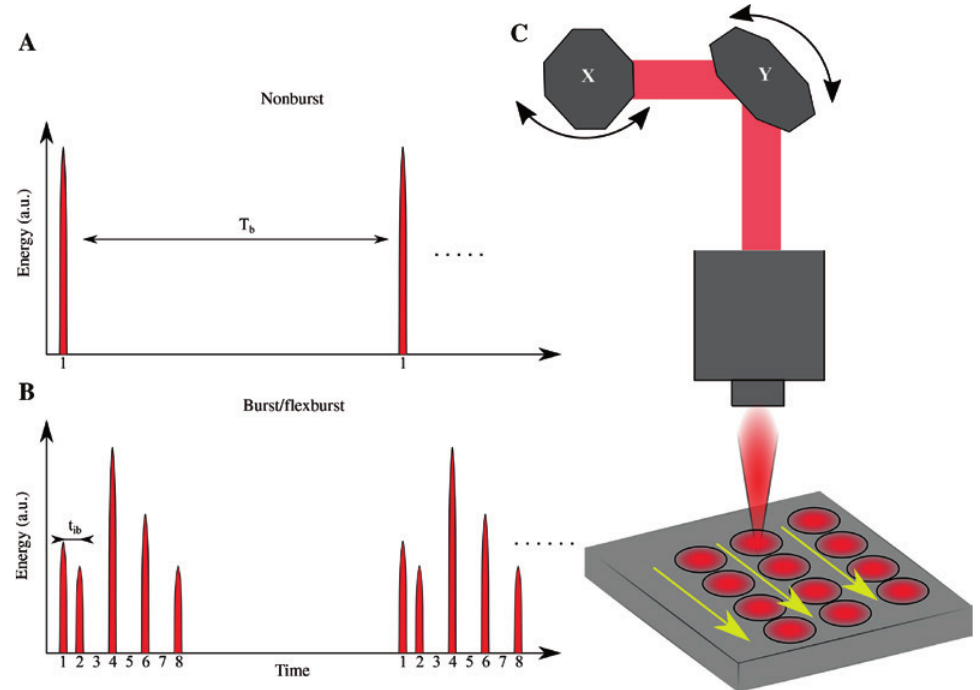
Figure 1: Experimental